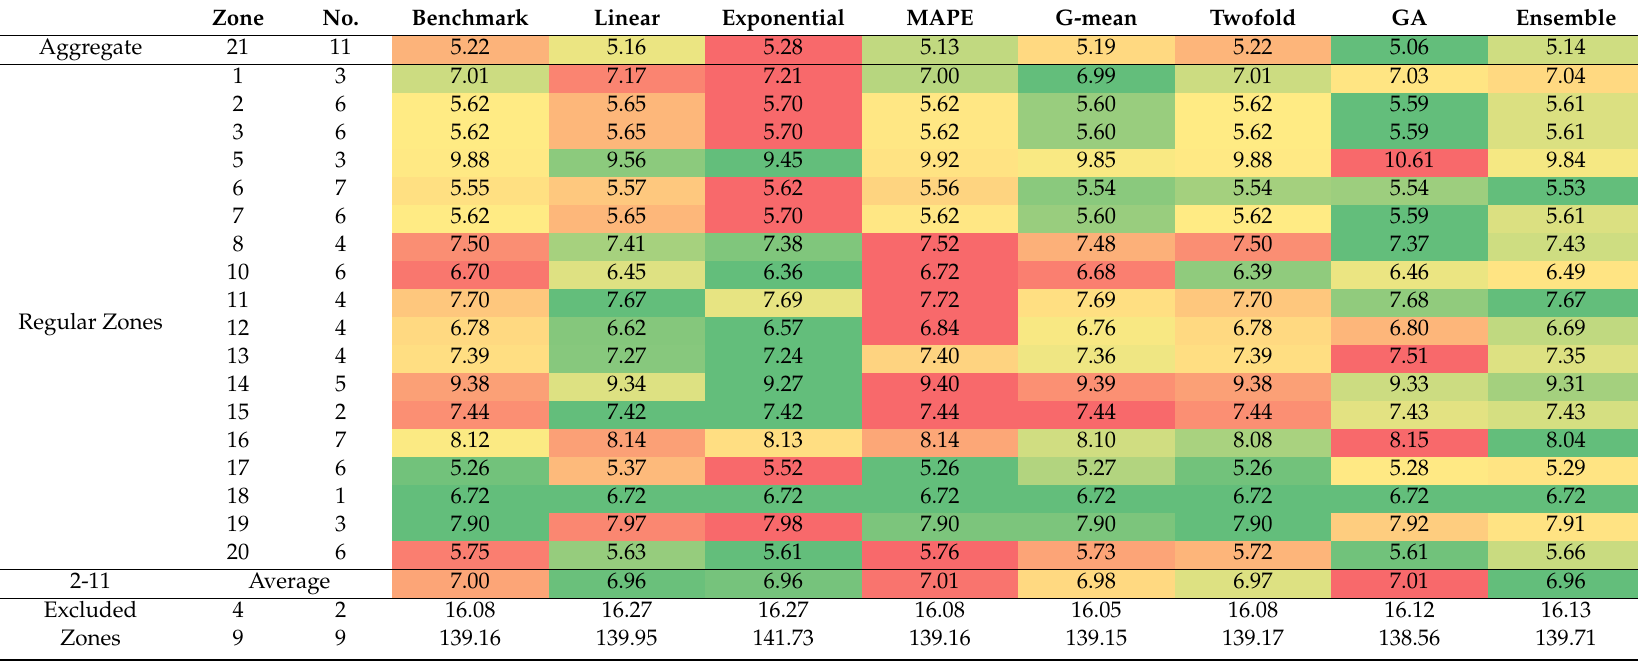
Table 2. Mean absolute percentage errors (MAPEs) of the load zones under di ff erent weather station combination methods. Zone No. Benchmark Linear Exponential MAPE G-mean Twofold GA Ensemble